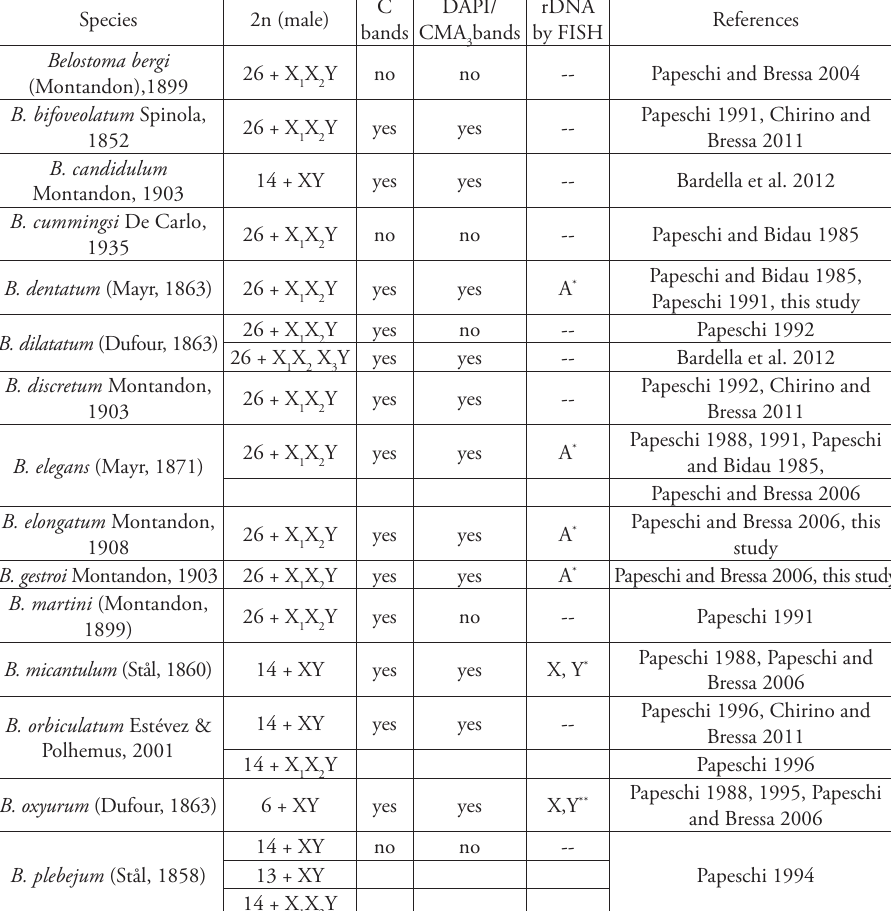
Table 1. Diploid chromosome number, chromosome bandings and nucleolar organizer region (NOR) detected by FISH in South American Belostoma species. *A: autosomal bivalent, **X, Y: sex chromosomes